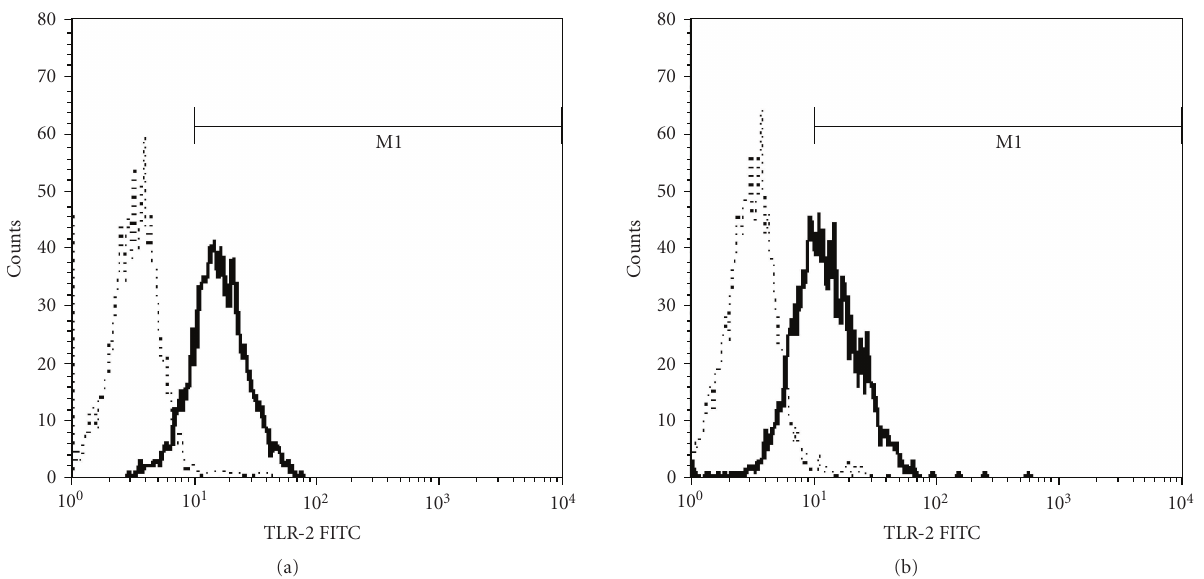
Figure 1: Representative FACS plots of TLR2 staining on PBMC. (a) SIRS; (b) non-SIRS. The non-specific binding is relatively small relative to specific binding as defined by the isotype controls. Dotted line represents the isotype control.